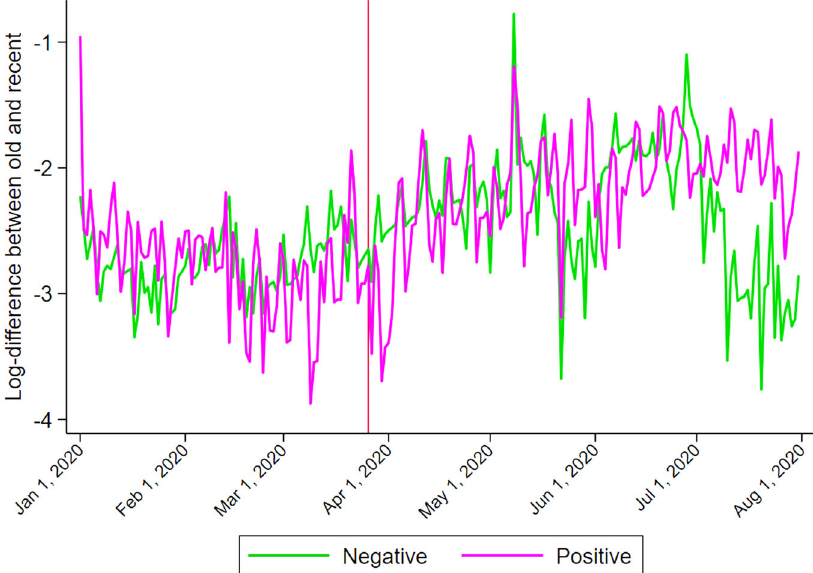
Fig. 10 Log difference in the total number of plays between old and recent songs. Source: Author ’ s illustration of Spotify